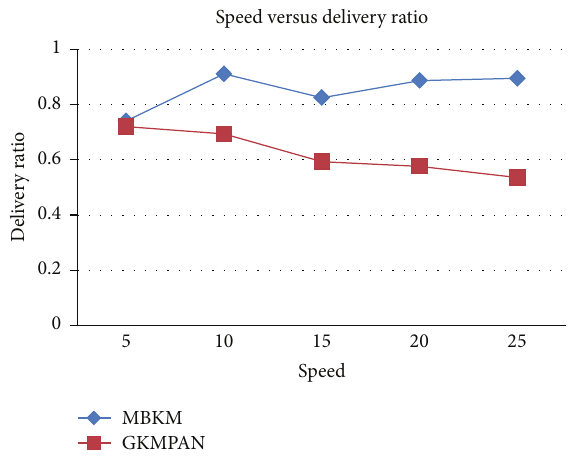
Figure 14: Speed versus delivery